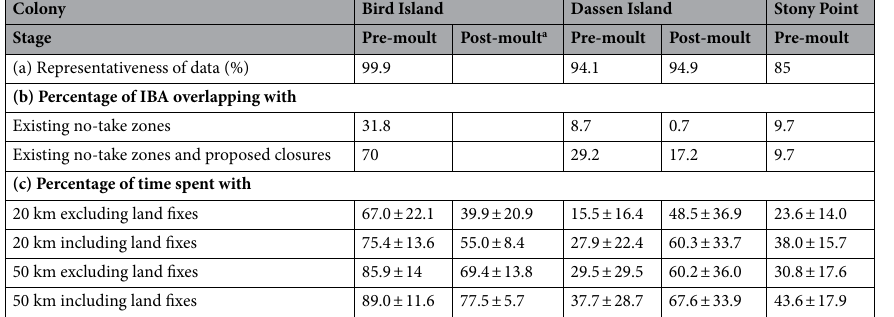
Table 3. (a) Representativeness of the Important Bird Areas (IBA) calculated for pre- and post-moult African penguins dispersing from three colonies. The percentage of spatial overlap between these IBAs with (b) existing no-take zones to purse-seine fisheries and 20 km radius around the four experimental no-take zones islands (Dassen, Robben, St Croix and Bird islands). (c) The percentage of time spent at-sea spent within 20 km and 50 km of dispersal colonies, including and excluding points on land. a IBA not estimated for data groups with fewer than 10